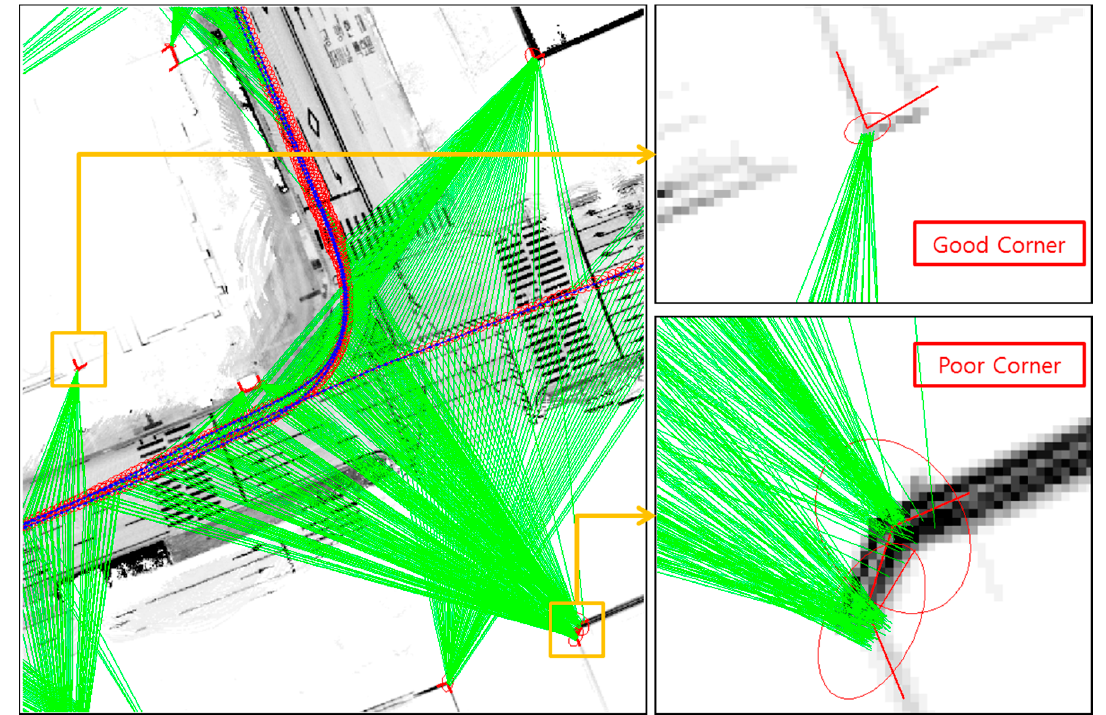
Figure 26. Examples of good and poor corners for the corner shape (the red ellipses on the corner represent the position error covariance of the extracted corners).